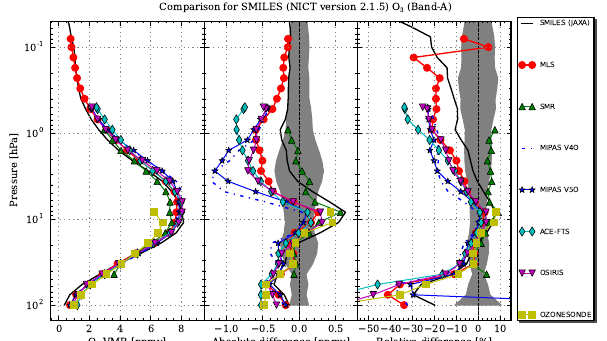
Fig. 23. Synthesis plots for O 3 profiles (left panel), mean absolute differences (middle panel) and mean relative differences (right panel) of profile comparisons. Each line shows global comparison between SMILES Band-A and another instrument. Dark gray zone indicates the systematic error of SMILES discussed in Sect. 2.3. 26